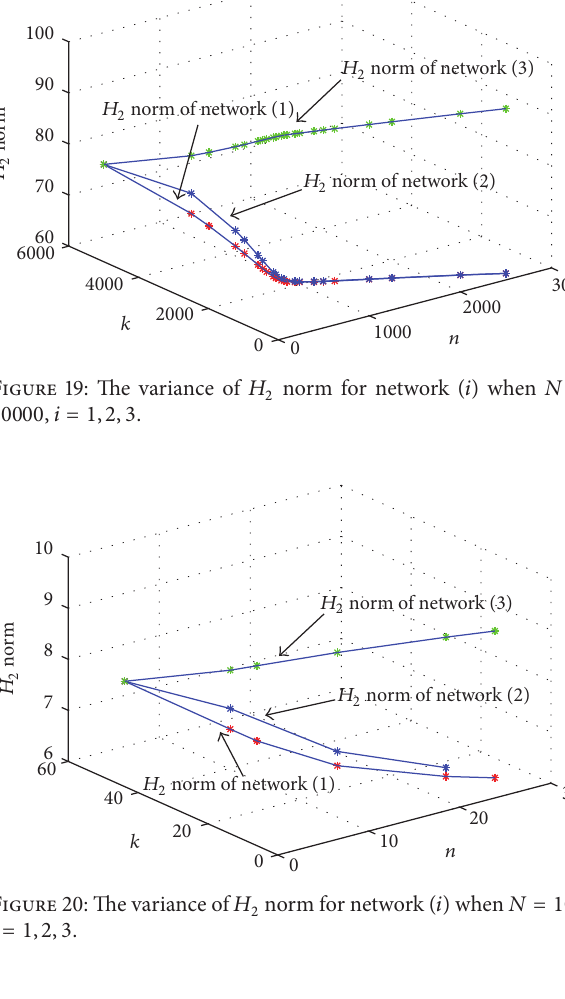
is the smallest of the three. The 𝐻 2 norm of network (1)